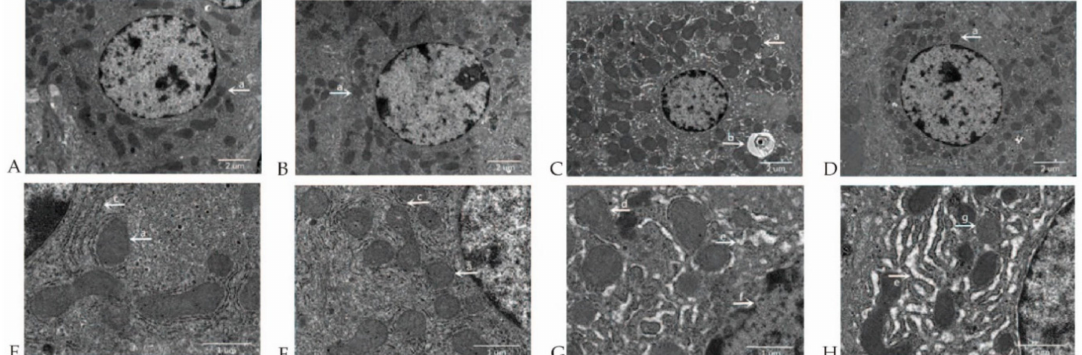
Figure 2. Effect of medium-chain triglyceride (MCT) supplementation on hepatocyte ultrastructure after 4-h LPS challenge in weanling pigs. Pigs were subjected to a 2 × 2 factorial study fed with or without 4% MCTs for 21 days, followed by an intraperitoneal injection of saline or LPS on day 22. The representative hepatocyte ultrastructural images from the four treatment groups were collected at 4 h after LPS challenge and processed for electron microscopy examination: ( A ) control diet